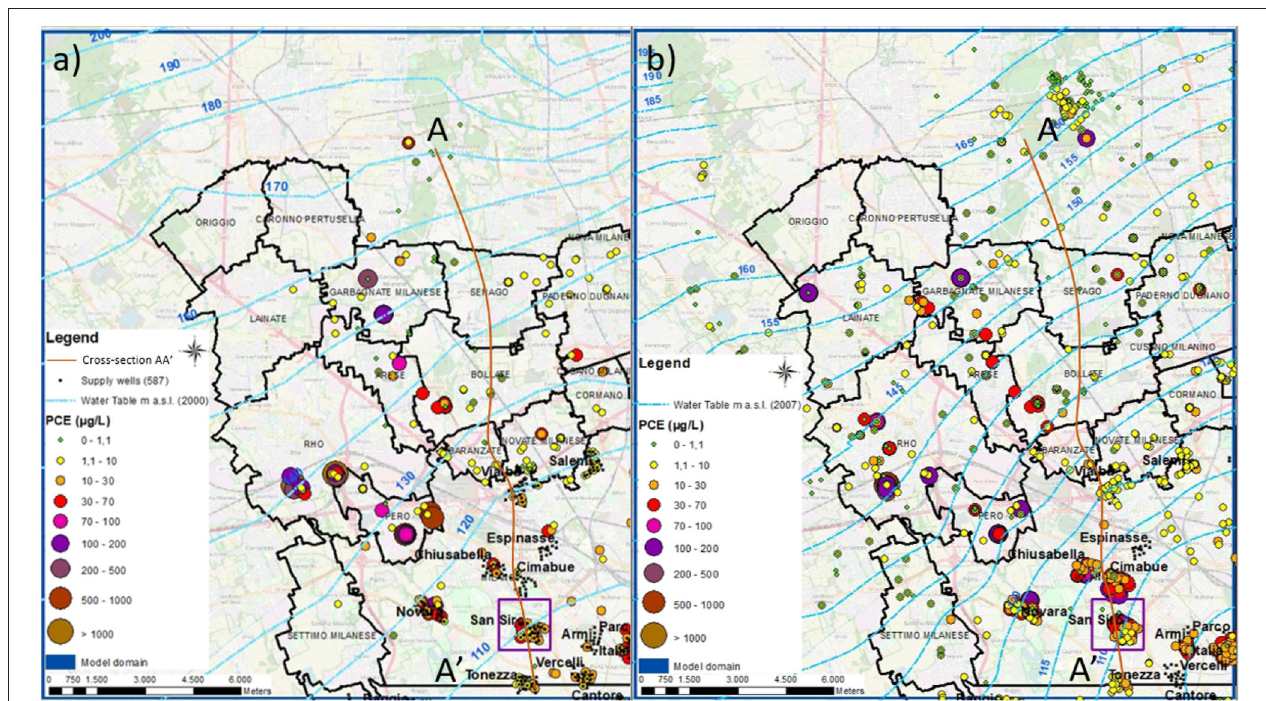
FIGURE 1 | Study area: FUA municipalities with black contours, PCE contamination sampled in (a) 2000 and (b) 2007 with the associated piezometric map. The cross-section AA ′ is described in the Supplementary Figure 1